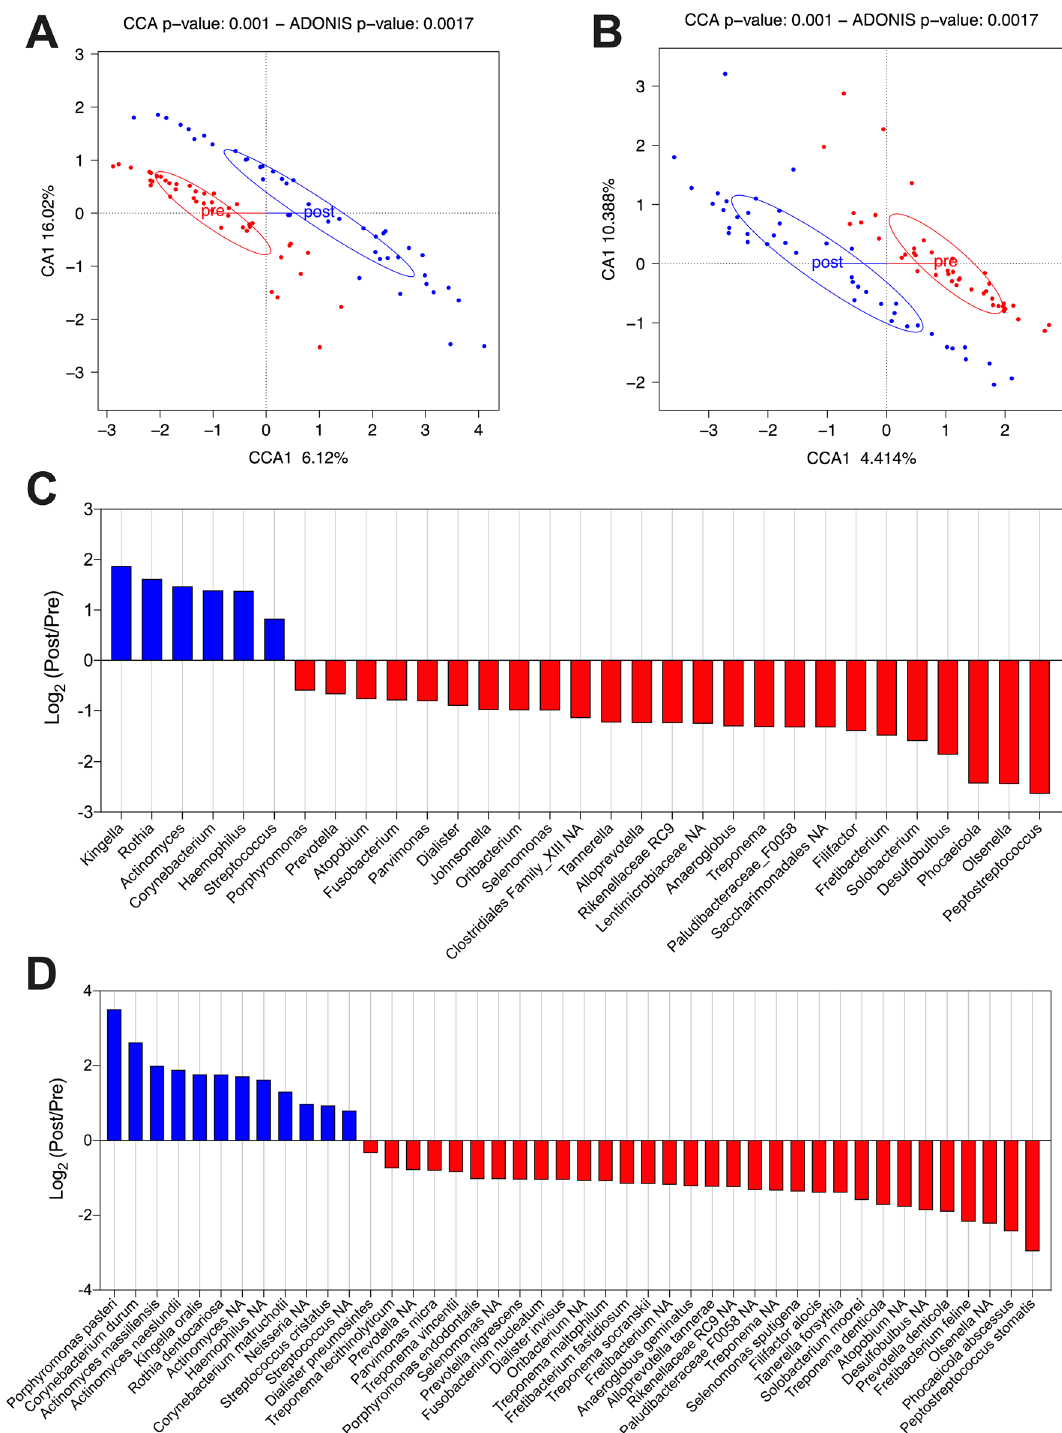
Figure 3. Assessing longitudinal changes in the composition of sub-gingival plaque samples following treatment. Canonical Correspondence Analysis (CCA) comparing baseline (red) and day-90 (blue) samples at genus- and species-level ( A and B respectively). Log 2 fold change of all significant genera ( C ) and species ( D ) with average abundance > 0.15% at either timepoint. Positive values (blue bars) indicate organisms which increased significantly following treatment, negative values (red bars) indicate organisms which decreased significantly following treatment. Wilcoxon signed rank test, corrected using Benjamini–Hochberg false discovery rate (5%). All plotted organisms p (adjusted) < 0.05. n = 42. NA indicates no classification was obtained at genus- or